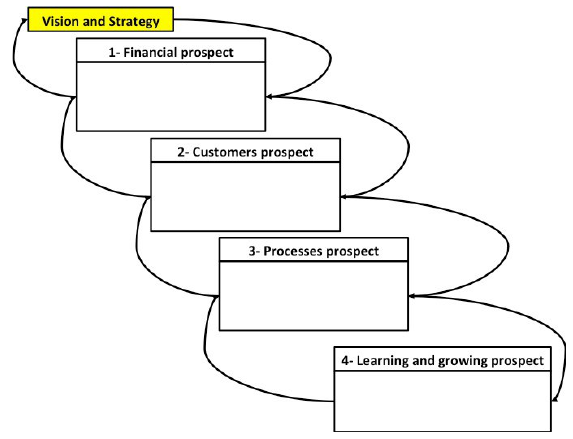
Figure 6. Balanced scorecard (Kaplan & Norton,